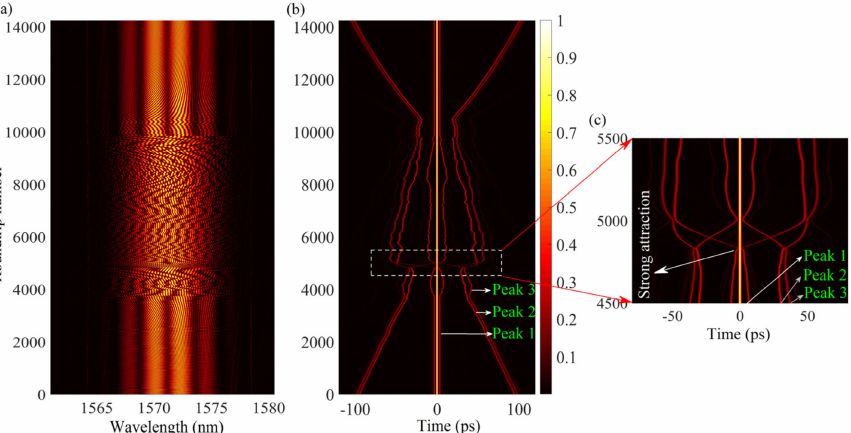
Figure 4. A typical single collision event. ( a ) Shot-to-shot spectra of 14,000 roundtrips, ( b ) the field autocorrelation traces obtained by Fourier transform of the shot-shot spectra in ( a ), and ( c ) zoom-in plot of the dashed rectangle in ( b ) which shows the bond exchange.